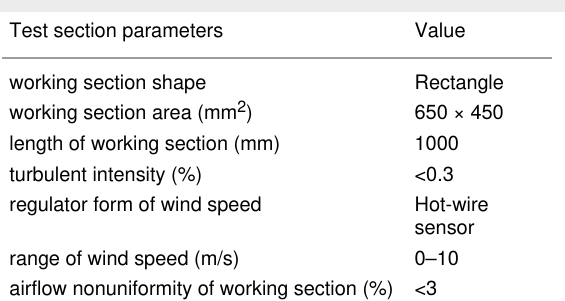
Table 2: Main parameters of the wind